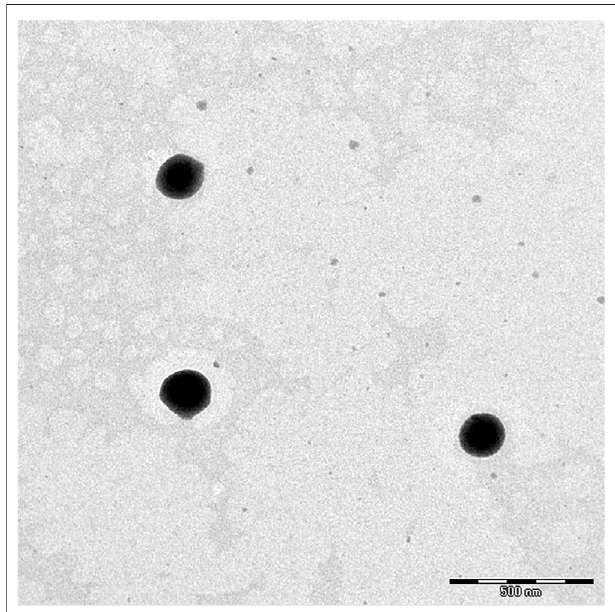
FIGURE 1 | TEM micrograph of niosomes at magni fi cation of ×